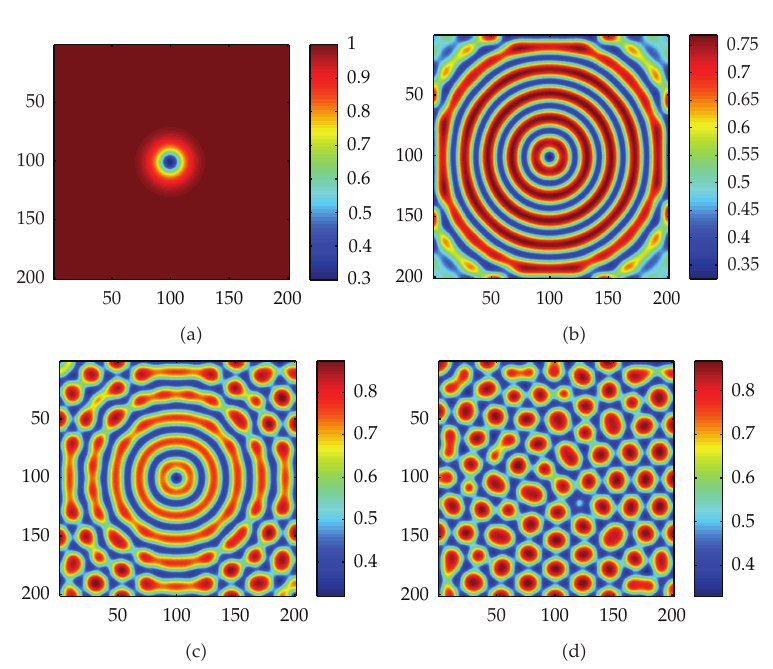
Figure 3: The process of spiral patterns of u for parameters: α (cid:5) 2 . 2, β (cid:5) 1 . 1, γ (cid:5) 1 . 05, d 11 (cid:5) 0 . 2, d 12 (cid:5) 0 . 05, d 21 (cid:5) 0 . 4, d 22 (cid:5) 0 . 2. Time: (cid:7) a (cid:8) t (cid:5) 50, (cid:7) b (cid:8) t (cid:5) 500, (cid:7) c (cid:8) t (cid:5) 1000, (cid:7) d (cid:8) t (cid:5) 2000.